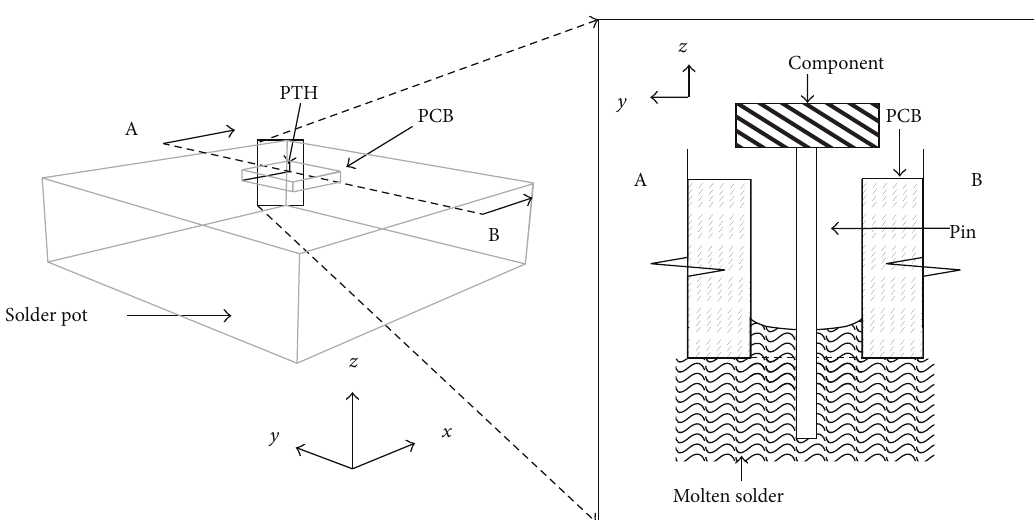
Figure 5: Cross-sectional view of computational domain at A-B.